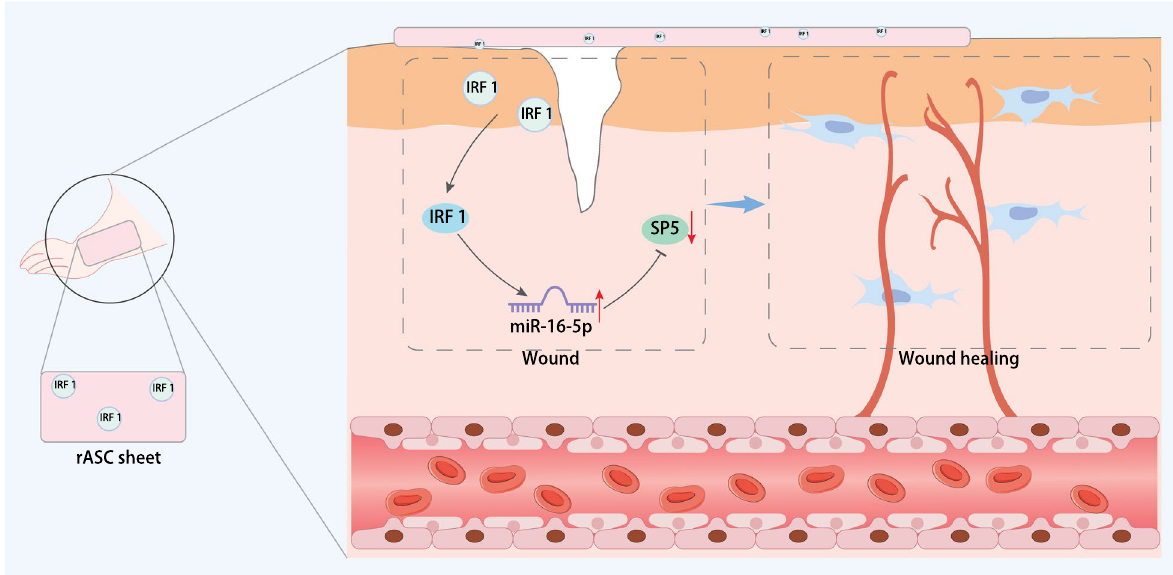
Fig. 9 Schematic representation of the molecular mechanisms whereby IRF1-exosome loaded into the rASC sheet affects foot wound healing in DM rats. IRF1 loaded into the rASC sheet can induce miR-16-5p expression and target SP5, consequently promoting fibroblast proliferation and migration and endothelial cell angiogenesis and accelerating foot wound healing in DM